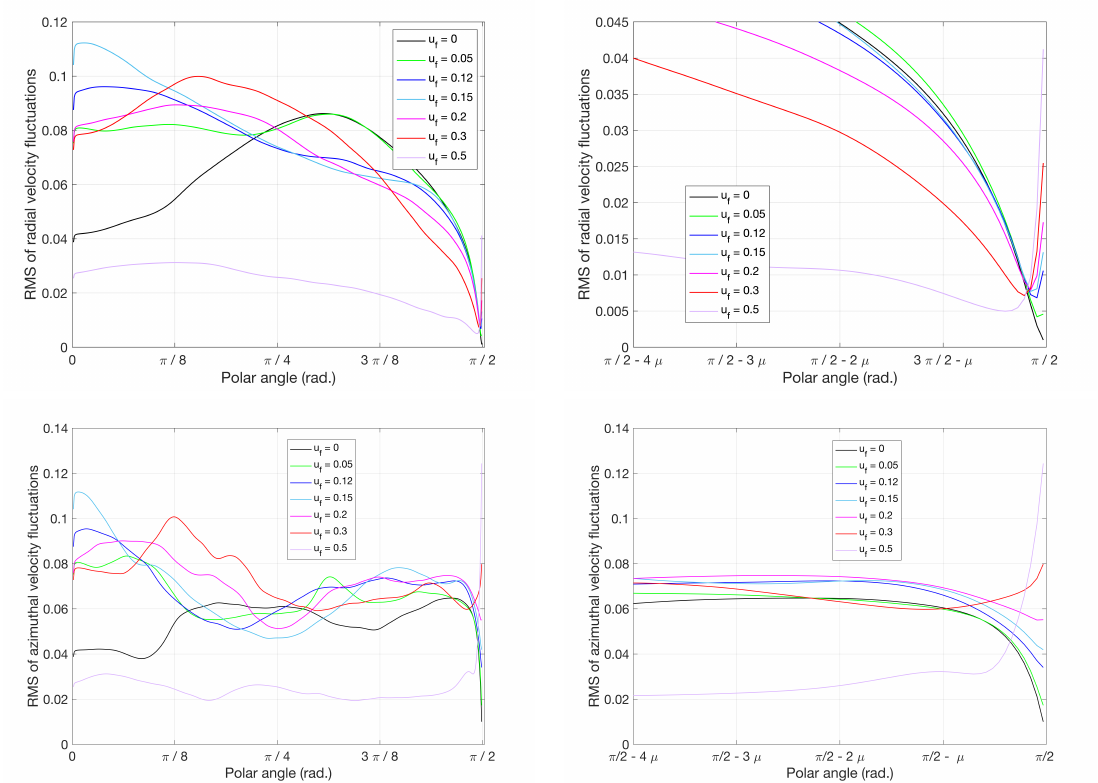
Figure 12. Velocity fluctuations RMS for various values of U f (method 2). Top: Radial velocity component. Bottom: Azimuthal velocity component. Right: Zoom close to the equator; µ =